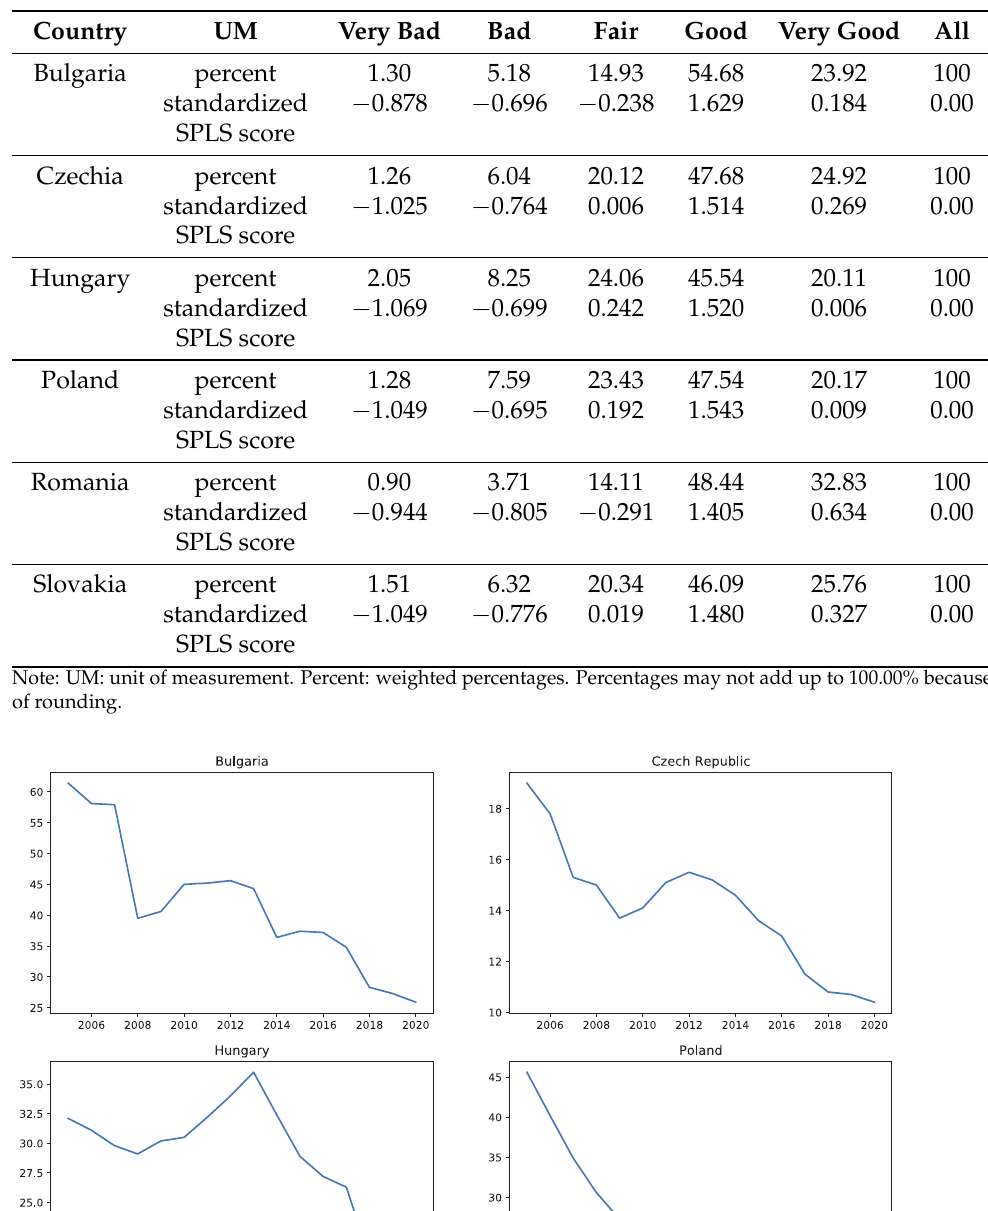
Table 1. The distribution of self-perceived life satisfaction scores.